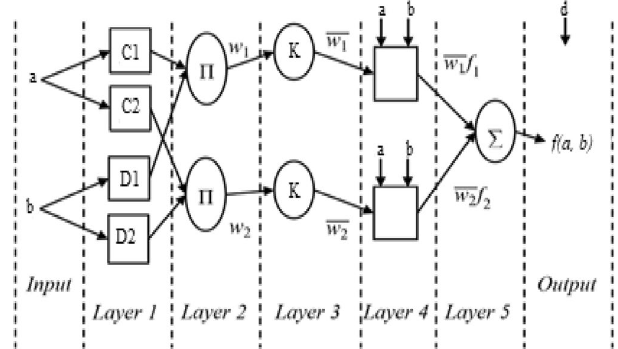
Figure 1. The ANFIS network